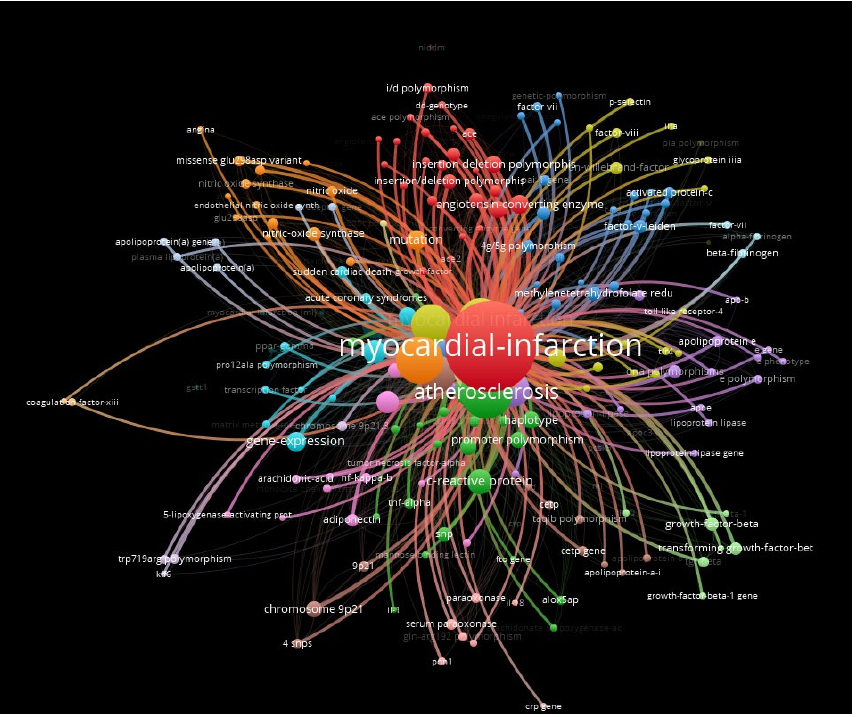
Figure 2. Web of Science map and network.